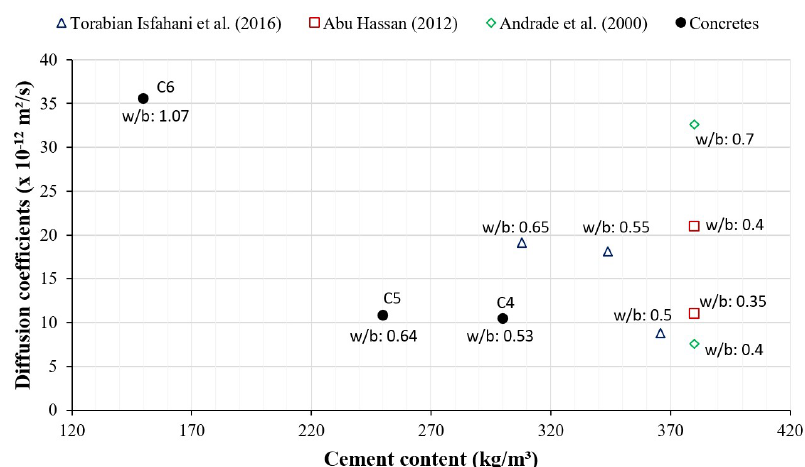
Figure 10. Diffusion coefficients – experimental and literature results; labels represent the water/cement